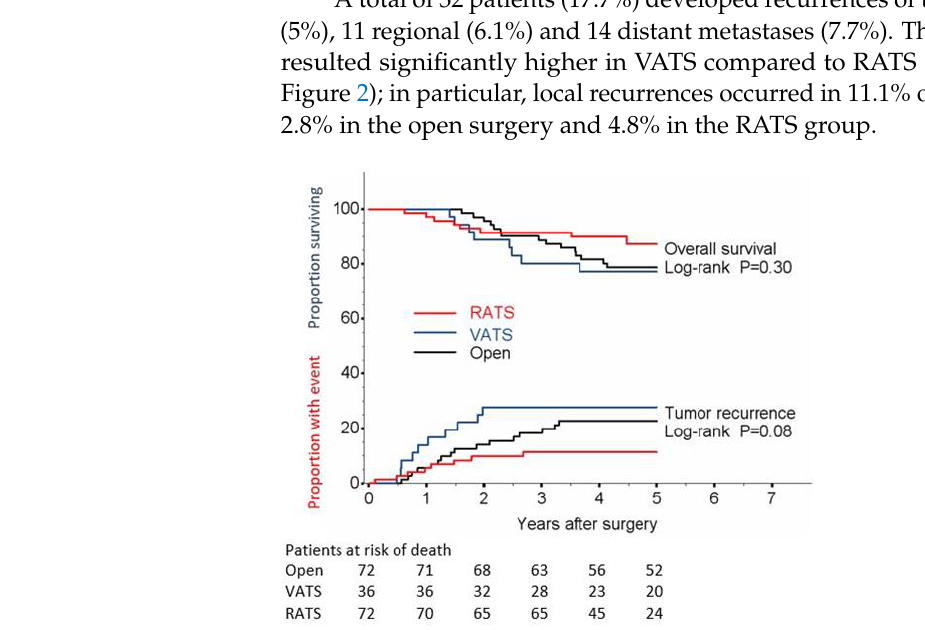
Figure 2. Tumor recurrence and overall survival.